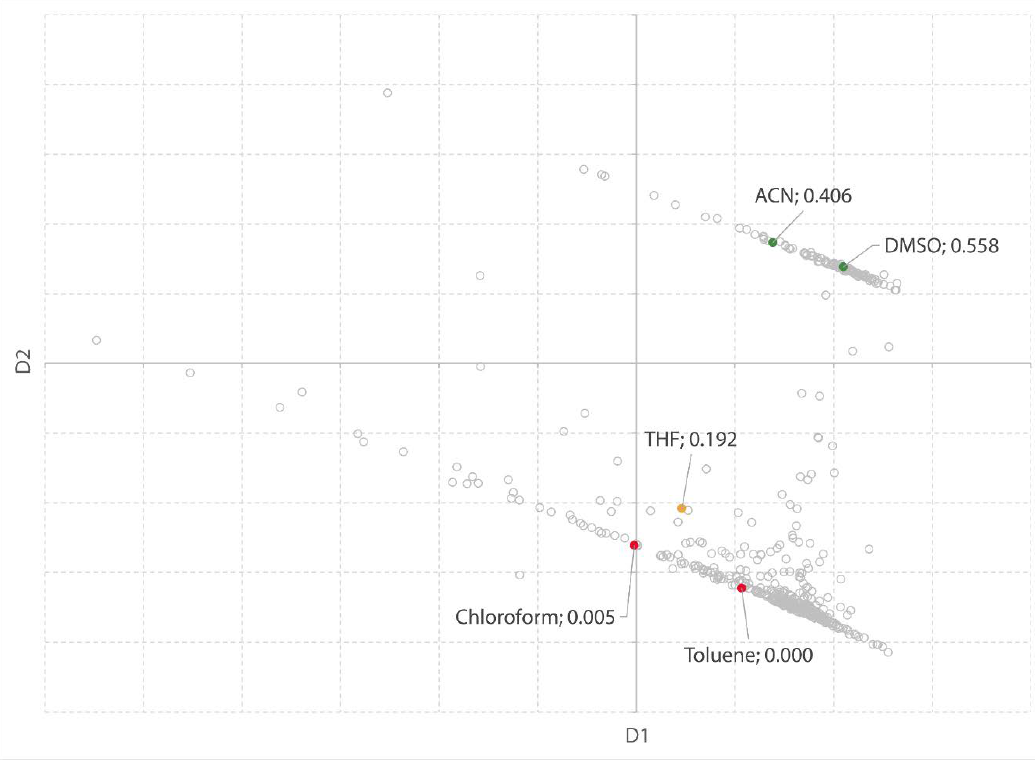
Figure 6. MDS plot with solvents highlighted in green (=high K T ), amber (=medium K T ), and red (=low K T ). Solvent names and K T values are shown as labels in the chart.